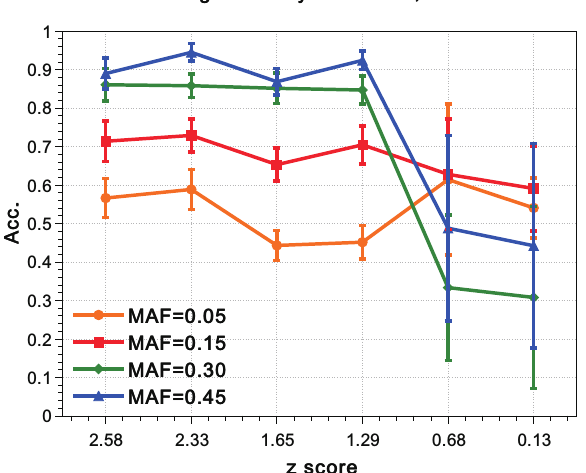
Figure 3. Matching Accuracy with m = 50, n = 100 . The z score z as 0.13, 0.68, 1.29, 1.65, 2.33, and 2.58 are expressed on the abscissa, respectively, while the matching accuracy is expressed on the ordinate. Matching accuracy with different MAFs and their standard deviations are expressed as different colored symbols with error bars, while the orange ellipse, red rectangle, olive diamond and blue triangle represent the MAF values of 0.05, 0.15, 0.30 and 0.45,